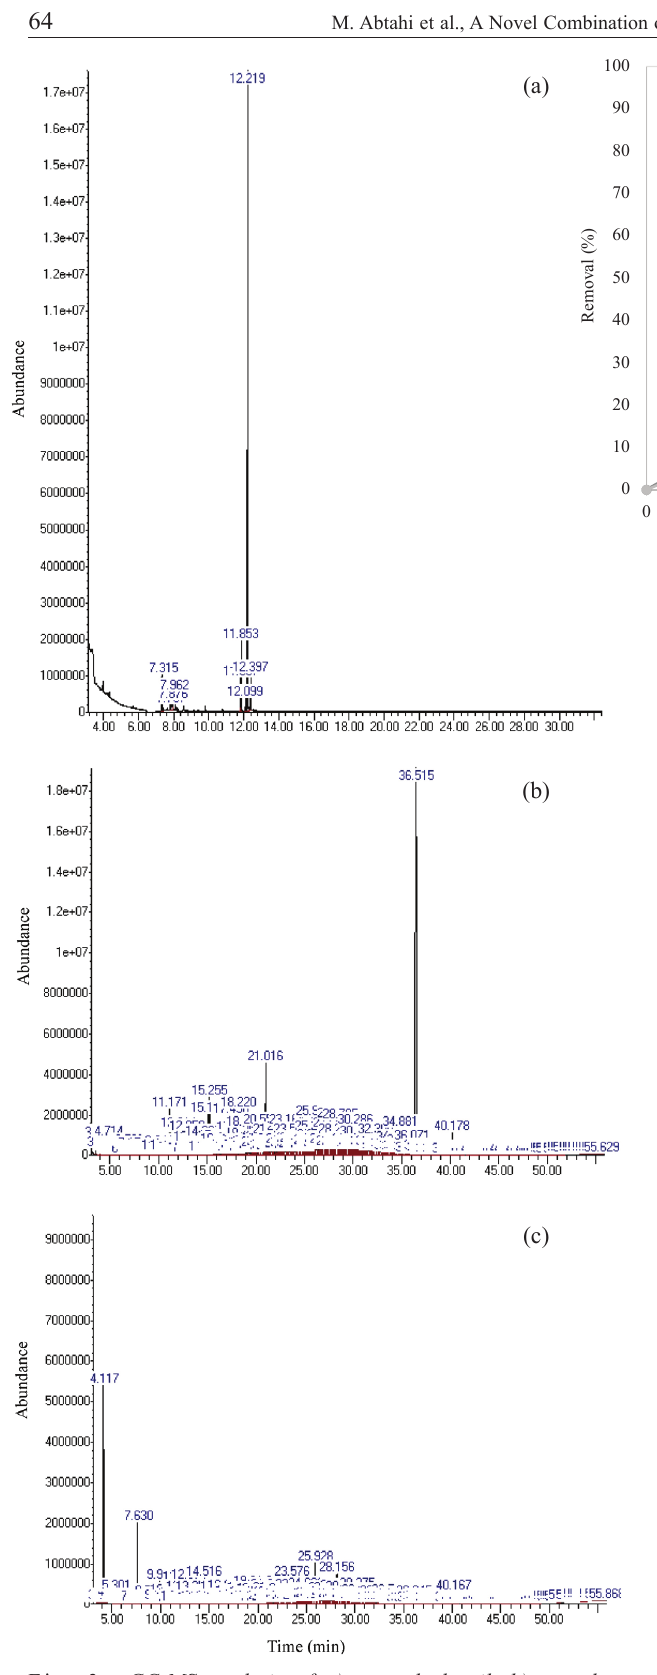
Fig. 3 – GC-MS analysis of a) unwashed soil, b) persul- fate-assisted EK remediation within 4 h, and c) persulfate-as- sisted EK remediation within 24 h under the selected conditions (Tween 80: 20 mL kg –1 , pH: 7 ± 0.3, voltage: 1 V cm –1 , moisture